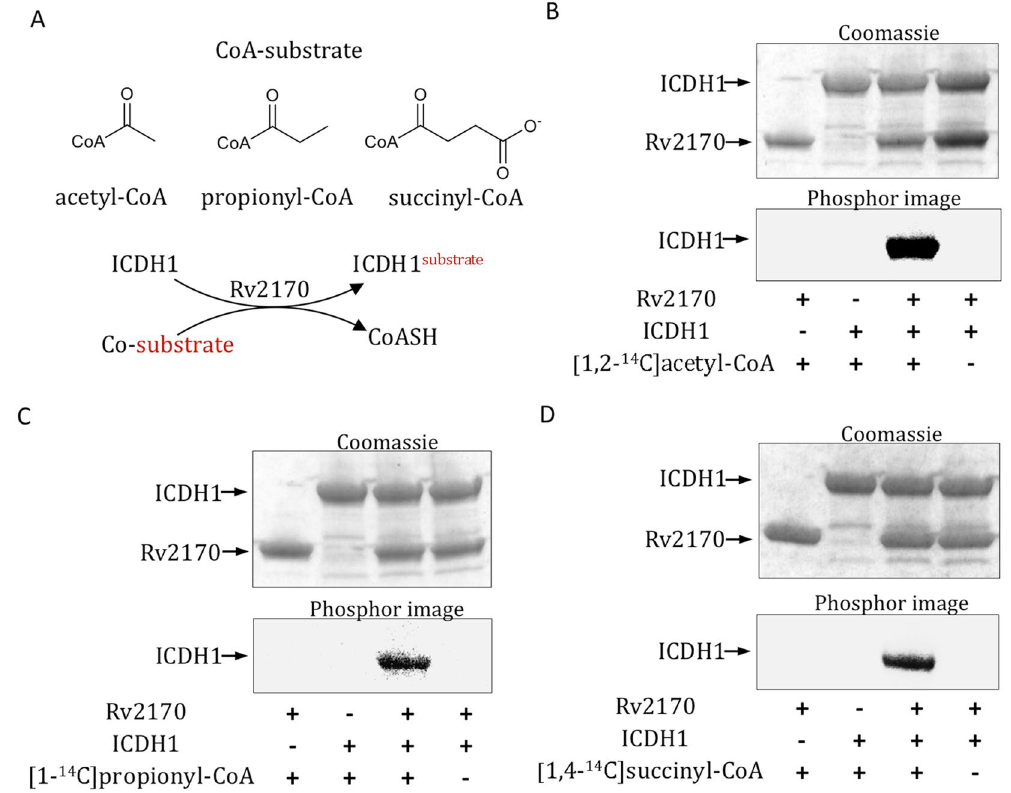
Figure 4. Rv2170 modifies ICDH1 using CoA substrates from TCA cycle and methylcitrate cycle. ( A ) The protein acetyltransferase Rv2170 modifies ICDH1 by using CoA substrates, acetyl-CoA, succinyl-CoA, and propionyl-CoA. ( B – D ) ICDH1 was incubated with [1,2- 14 C] acetyl-CoA ( B ), [1- 14 C] propionyl-CoA ( C ), or [1,4- 14 C]succinyl-CoA ( D ) in the presence or absence of Rv2170. Proteins were resolved by SDS-PAGE and visualized with Coomassie Blue. Acetylation of proteins was detected by phosphor